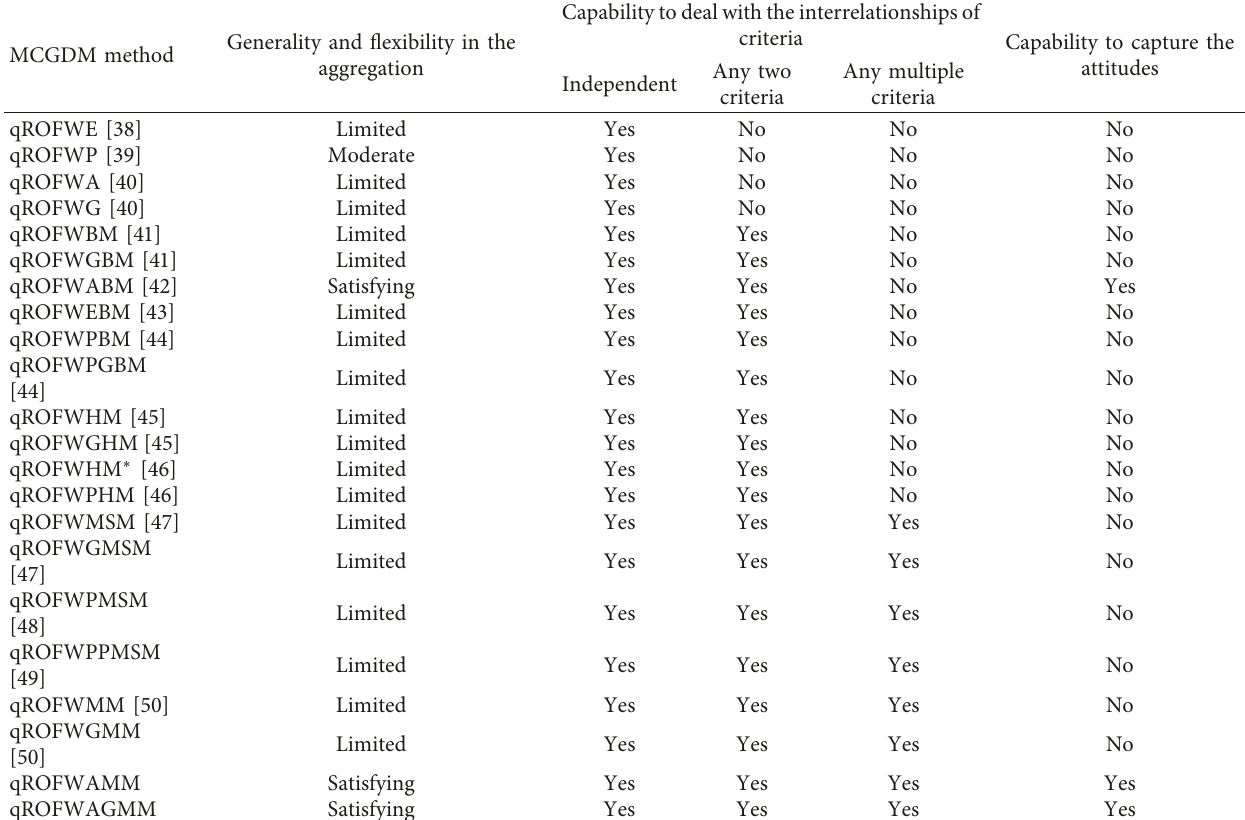
Table 5: The results of the qualitative comparison with the MCGDM methods based on aggregation operators of qROFNs. Generality and flexibility in the MCGDM method aggregation